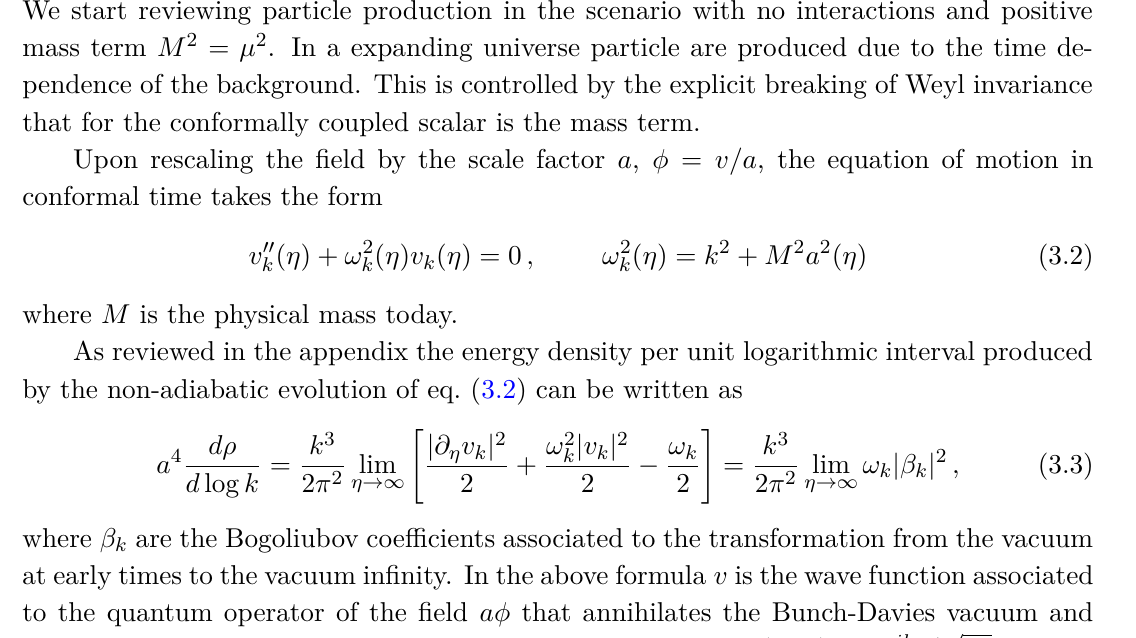
= 0 . 01 and it is cut-off at k I